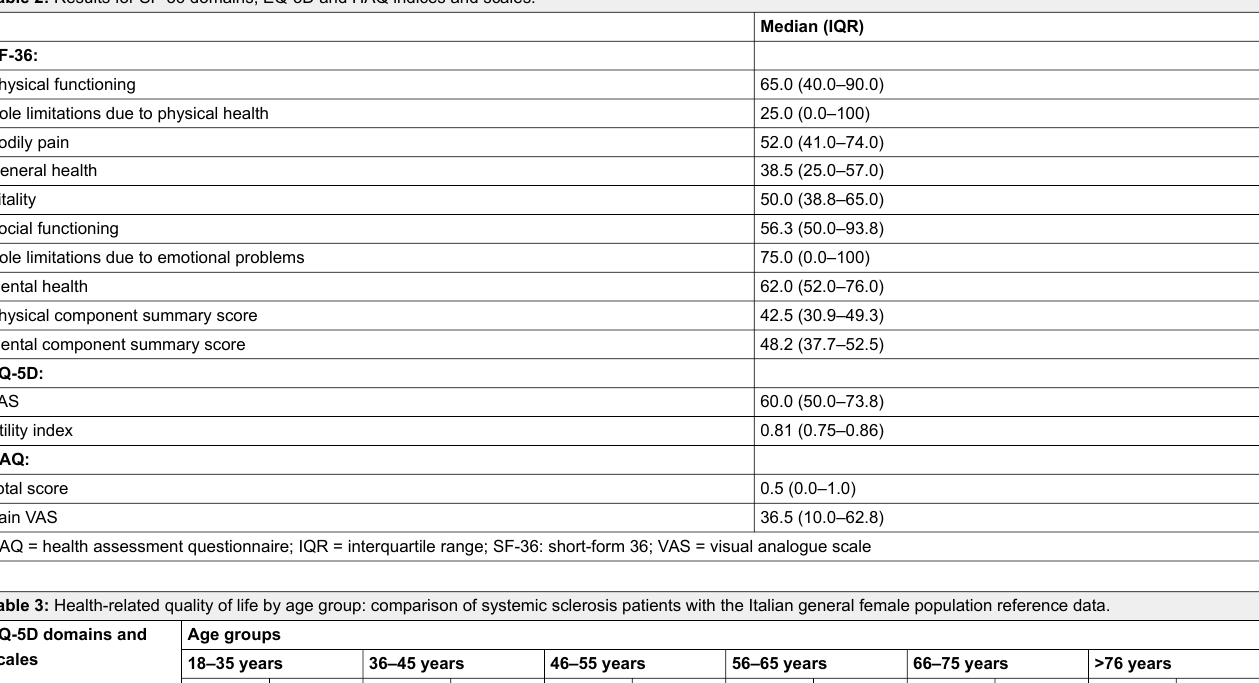
Table 2: Results for SF-36 domains, EQ-5D and HAQ indices and scales.